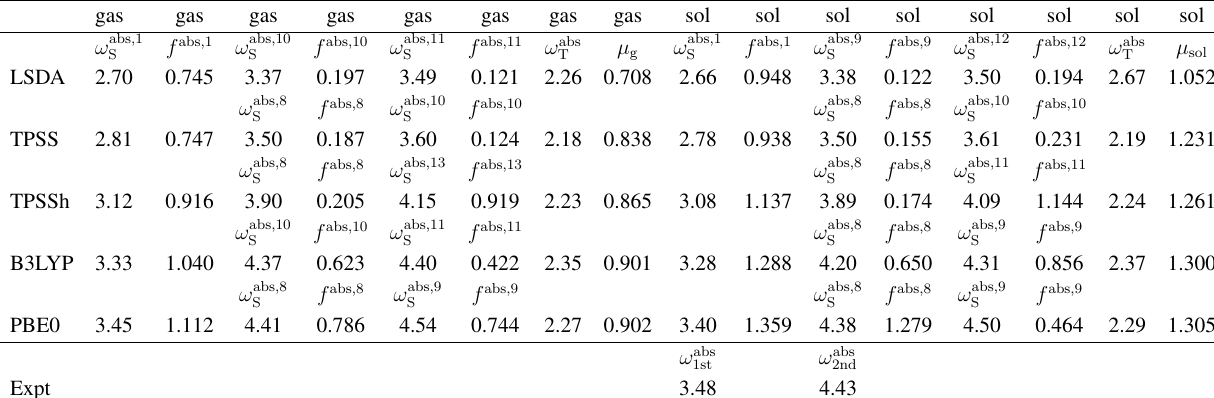
Table 11. B1PPQ: Singlet and triplet vertical excitation energies ( ω n excited state) in eV, the transition oscillator strength ( f abs , n ), and the dipole moment of the ground state in Debye of B1PPQ molecule in gas phase ( µ ( µ ), calculated using the five adiabatic density functionals with the basis set 6-31G(2df,p) sol and the geometry optimized on the respective density functionals with the same basis. (1 eV = 8065.5 cm − 1 = 0.03675 hartree; The energy (in units of eV) of wave length λ (in units of nm) is hc/λ = (nm /λ )1239 . 84 eV, where h is Planck’s constant and c is the speed of light). Experimental values measured in chloroform are obtained from Ref. [1].